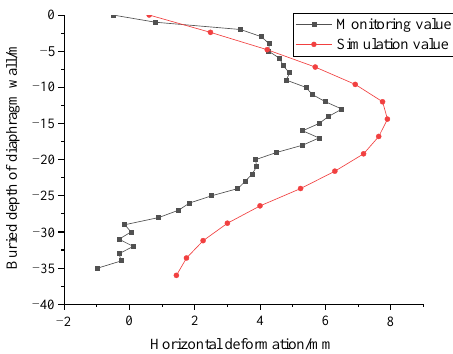
Figure 11. Horizontal deformation comparison diagram of ground wall.